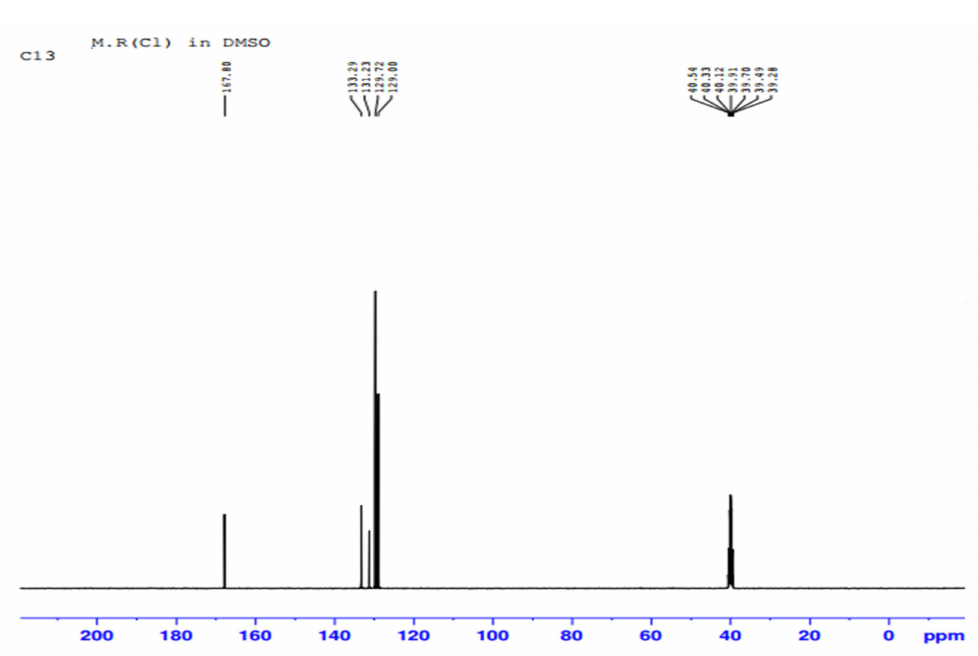
Figure 17. 1 H NMR of metabolite.